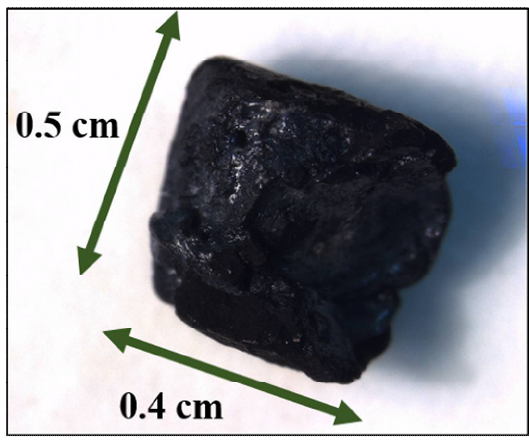
Figure 1. Photograph of the SWNH-monolith.